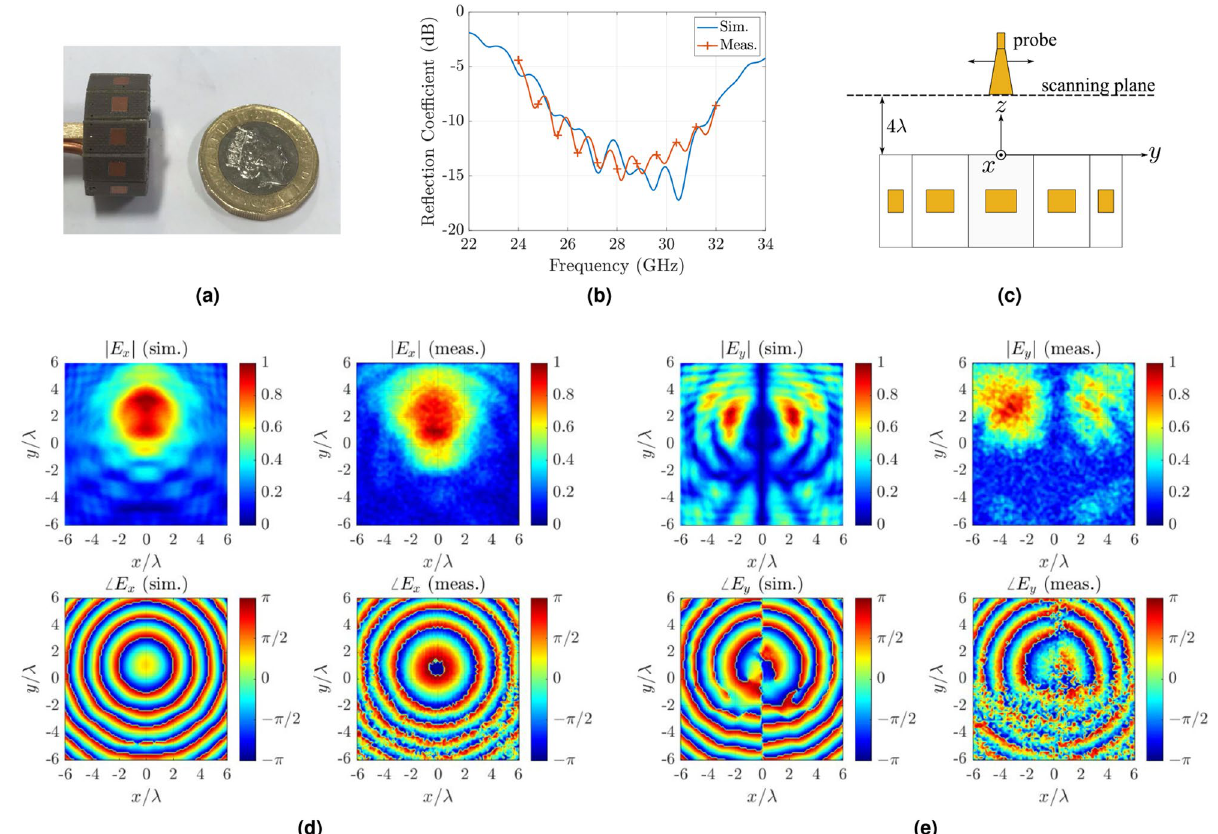
Figure 4. ( a ) The fabricated and tested circular antenna array: only a single element is fed by a 50 (cid:31) coaxial cable and all the other ports are open-circuited. ( b ) Comparison between simulated and measured reflection coefficient at the end of the coaxial cable: a good-agreement is observed. ( c ) The near-field measurement set-up: probe, which is connected to VNA measures the electric field (i.e., E x and E y component) when the antenna transmits at 28 GHz. Comparison between simulated and measured E x -, E y -field patterns in the form of normalized magnitude and phase: a good agreement is